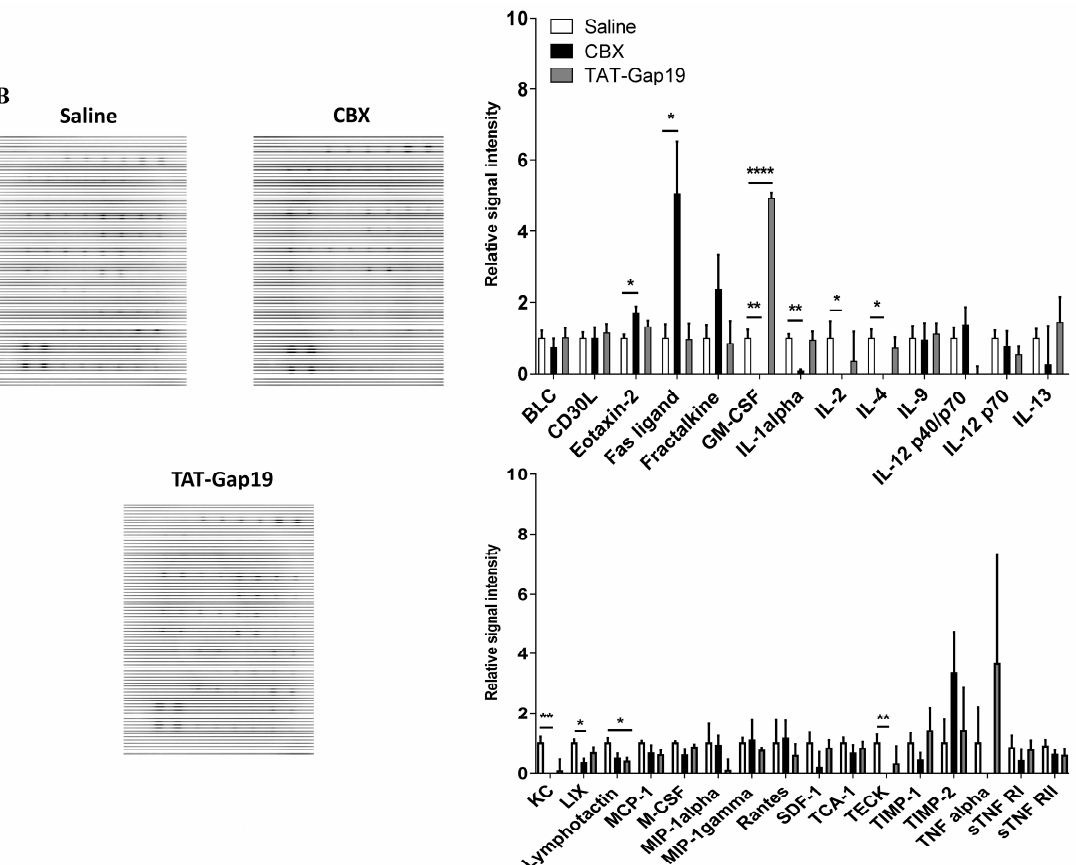
Figure A2. Effects of CBX and TAT-Gap19 on the inflammatory response after TAA-induced chronic hepatic injury in mice. Mice were administered TAA intraperitoneally for 8 weeks. Initially, mice ( n = 4/group) were administered with 100 mg TAA/kg body weight, followed by 10% weekly increments to the utmost dose of approximately 200 mg TAA/kg body weight. Thereafter, an osmotic pump was implanted in the peritoneal cavity, which ensured the release of 1 mg TAT-Gap19 or CBX/kg body weight/day or saline for 2 weeks. ( A ) Antibody array map with the inflammatory proteins. ( B ) Representative antibody array membranes from mouse liver tissue extract corresponded to animals treated with saline, CBX or TAT-Gap19. Data were analyzed by densitometric analysis. Then, background was subtracted and results were normalized against the average of positive controls. Results were analyzed by 1-way ANOVA followed by post hoc Bonferroni correction. Data were expressed as means ± SEM (* p ≤ 0.05; ** p ≤ 0.01; **** p ≤ 0.0001). (BLC, B lymphocyte chemoattractant; CD30L, tumor necrosis factor ligand superfamily member 8; Eotx, eotaxin; Frck,